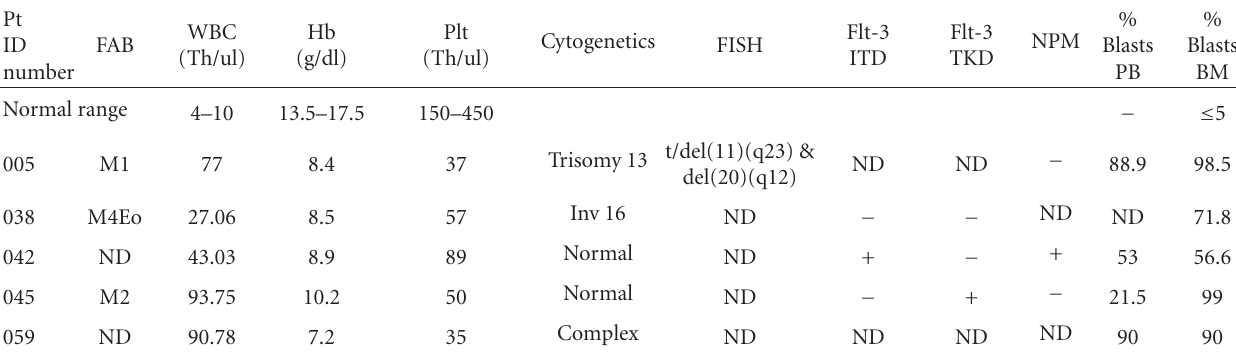
Table 1: Patient clinical